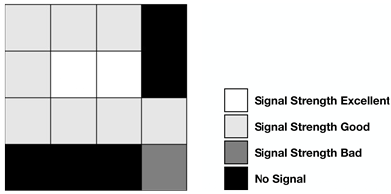
Figure 6. Graph of radio wave strengths received by mobile phones (strengths are indicated in descending order, i.e., white, light gray, dark gray, and black).